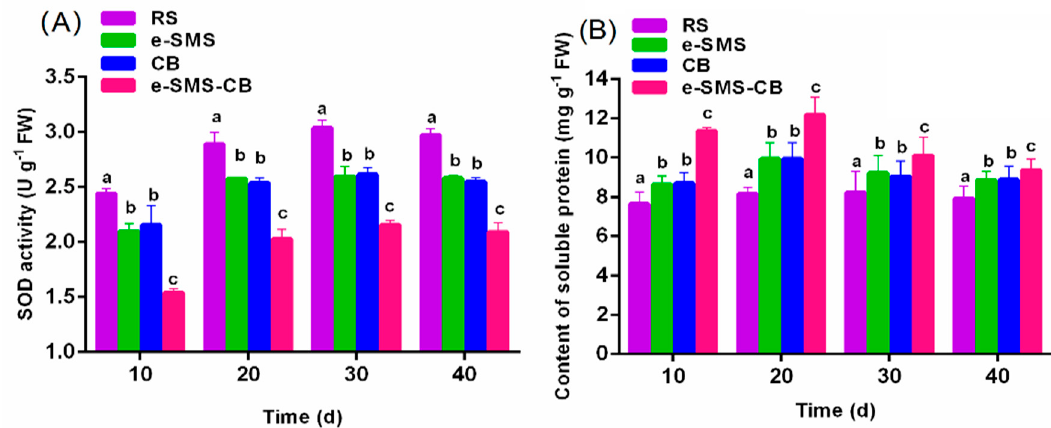
Figure 6. Effects of chlorimuron-ethyl on Superoxide dismutase (SOD) and Soluble protein (SP) of wheat with the increasing incubation time. (A) SOD activity and (B) SP content. The bars represent the SDs of assays performed in triplicate. Bars with different letters are significantly different at the P < 0.05 level. RS: real soil as control group; e-SMS: real soil + P. eryngiu -SMS; CB: real soil + co-culture bacteria; e-SMS-CB: real soil + P. eryngiu -SMS-CB.